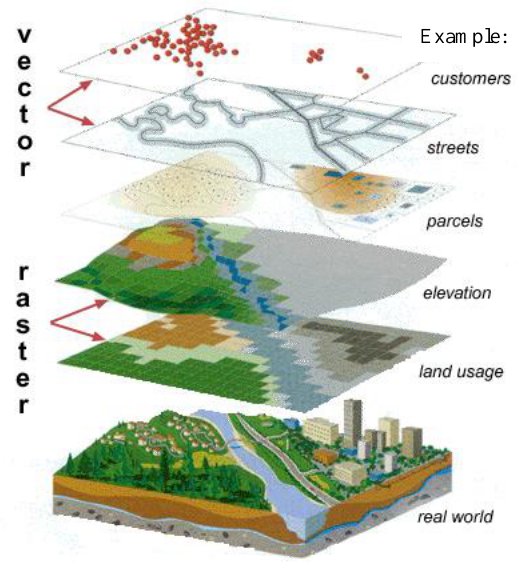
Figure 2. Illustration of vector and raster data model in GIS.